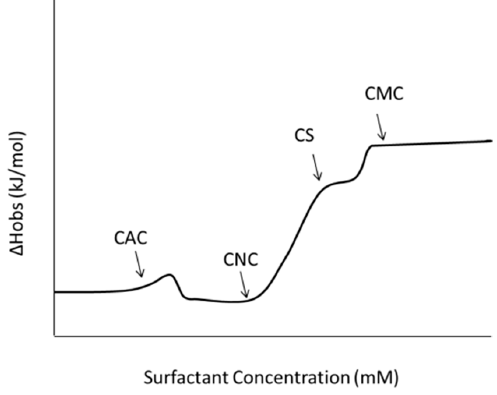
Figure 6. General depiction of observed enthalpy versus increasing surfactant concentration for polyelectrolyte and surfactant systems.